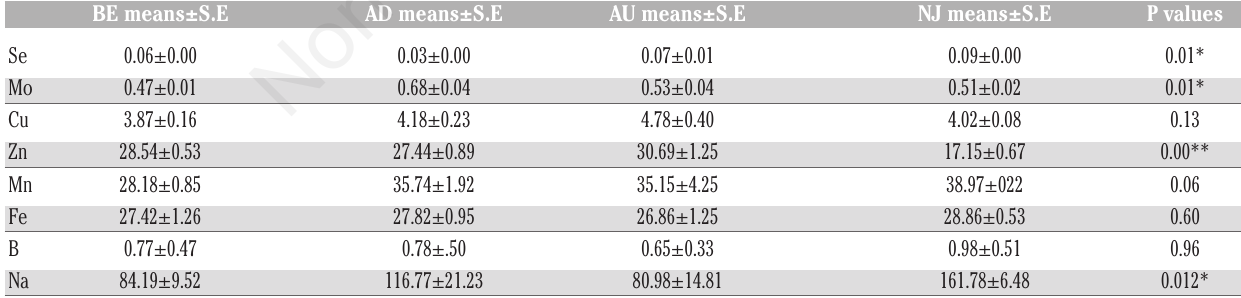
Table 2. Grain concentrations (mg/kg DW) of mineral micronutrient elements of the four wheat genotypes. BE means±S.E